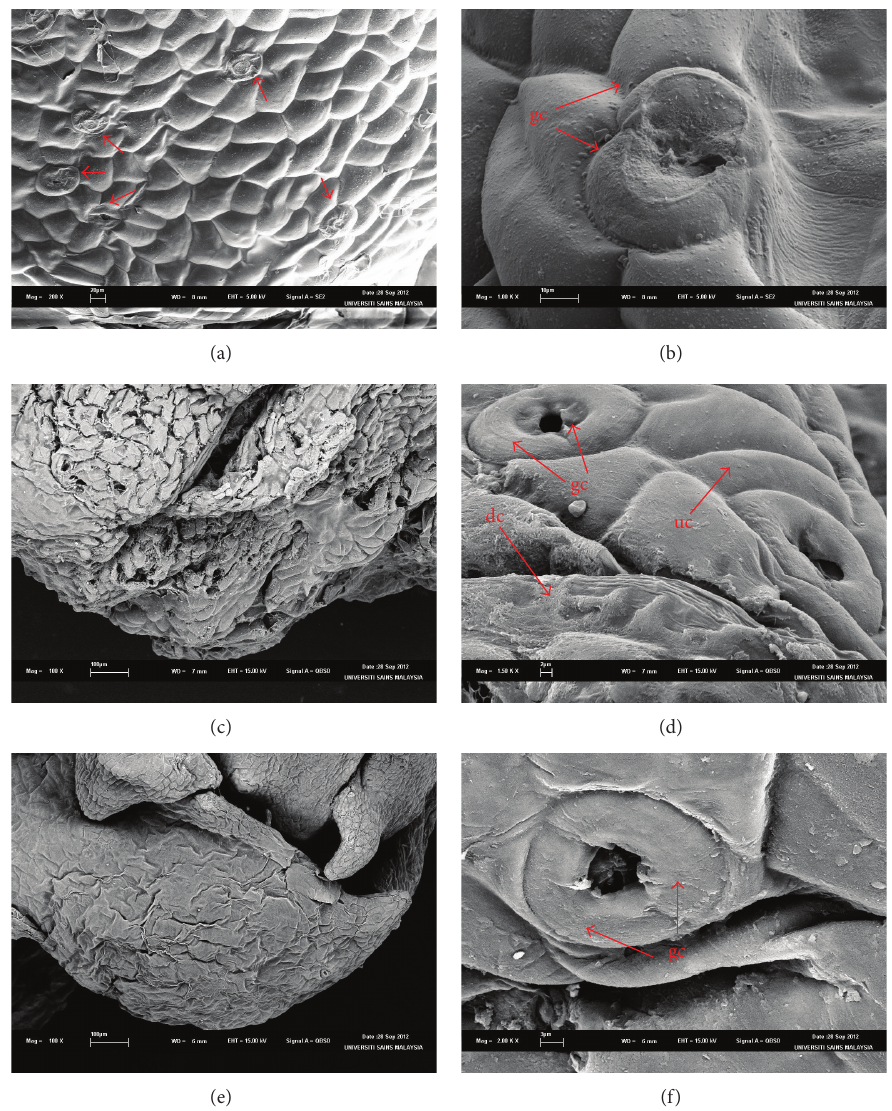
Figure 4: Scanning electron microscopic of stock culture, cryopreserved and noncryopreserved PLBs. (a) stock culture PLB with dense stomata on its surface (arrows), (b) higher magnification of stomata in stock culture PLB, (c) cryopreserved PLB showing damage, (d) higher magnification of cryopreserved PLB showing stomata and damage and undamaged cells, (e) noncryopreserved PLB shrunk, and (f) higher magnification showing stomata of noncryopreserved PLB (dg: damage cell; gc; guard cell; ud: undamaged